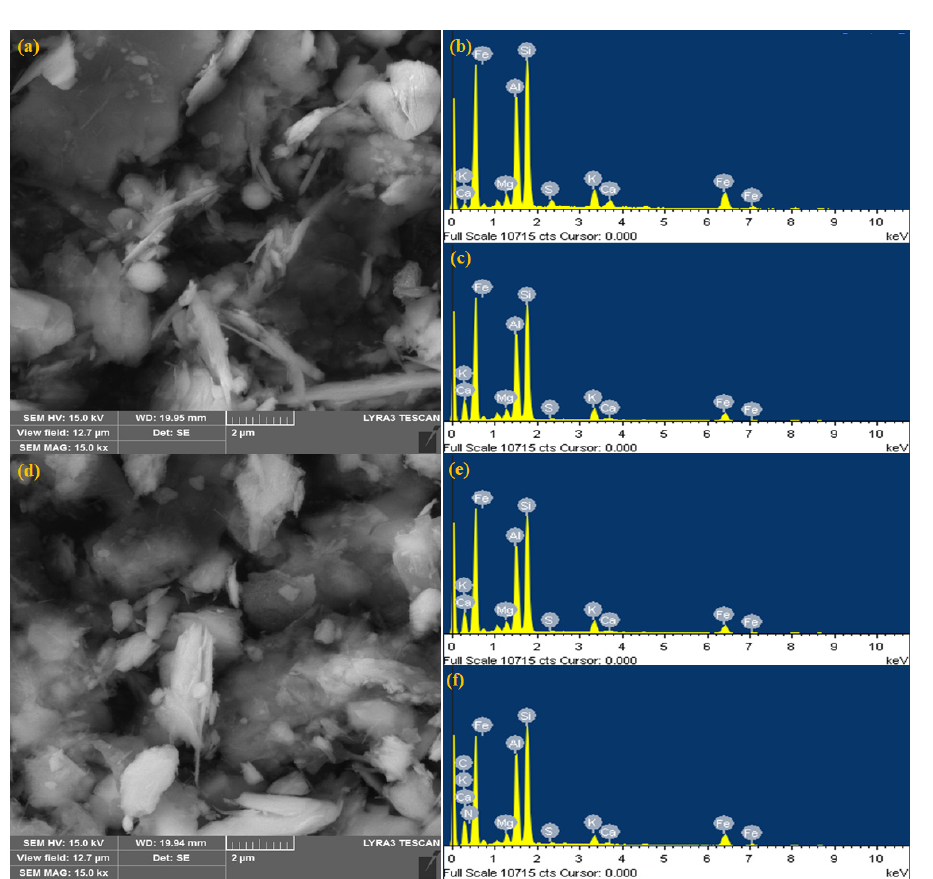
Figure 4. SEM image ( a ), and EDX analysis of NCQ1 ( b ), SEM image ( d ), and EDX analysis of NCQ3 ( e ), EDX analysis after CV dye adsorption onto NCQ1 ( c ), and NCQ3 ( f ) adsorbents.